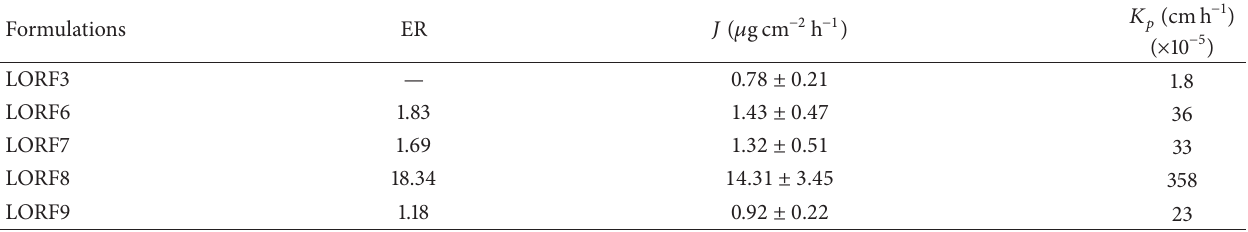
Table 3: Percutaneous permeability parameters of LOR formulations through rabbit skin.